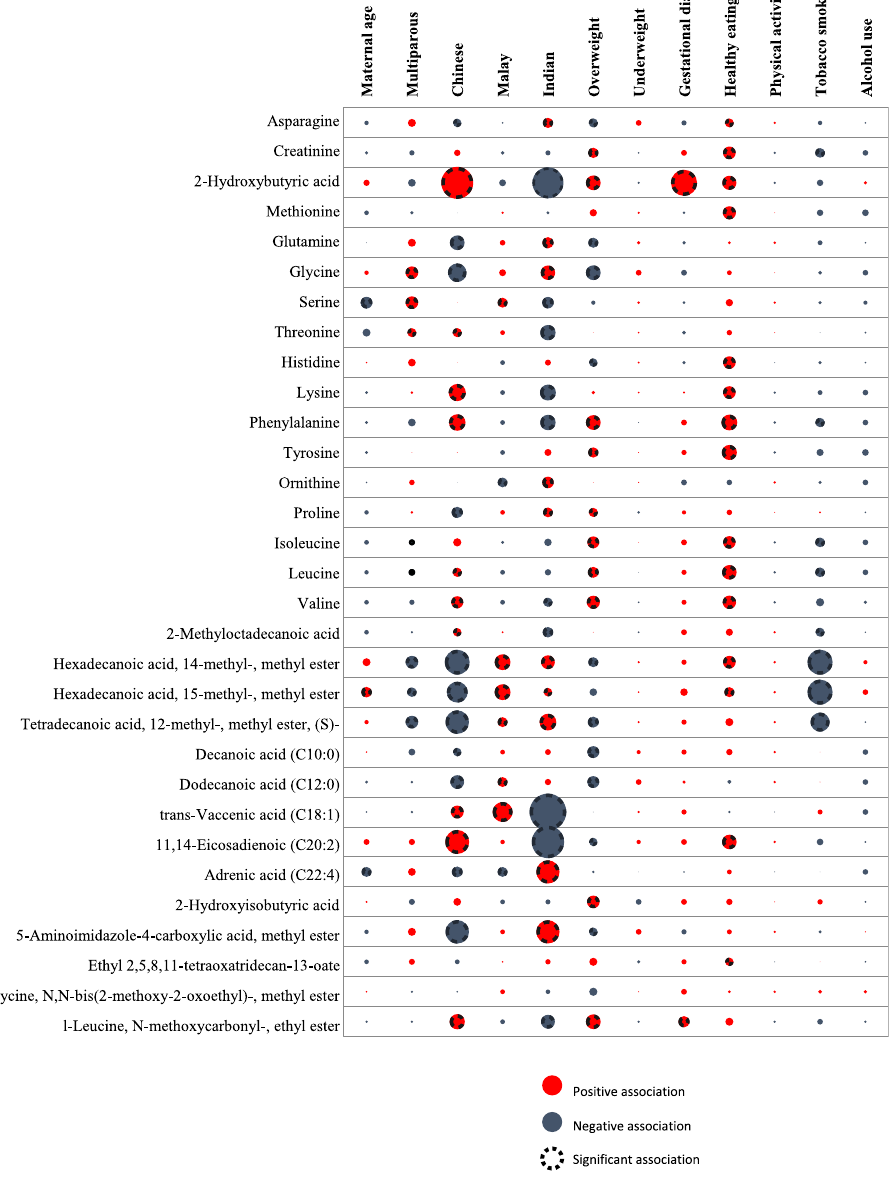
Figure 1. Maternal characteristics and infant adiposity-related metabolites. Multiple linear regression was performed with metabolite z-scores modelled as dependent variables and maternal characteristics as independent variables. Each circle denotes negative log-transformed q-values derived by the Benjamini- Hochberg procedure. Larger circles represent a lower q-value (i.e., a lower false discovery rate). (description for ‘Positive association’, ‘Negative association’ and ‘Significant